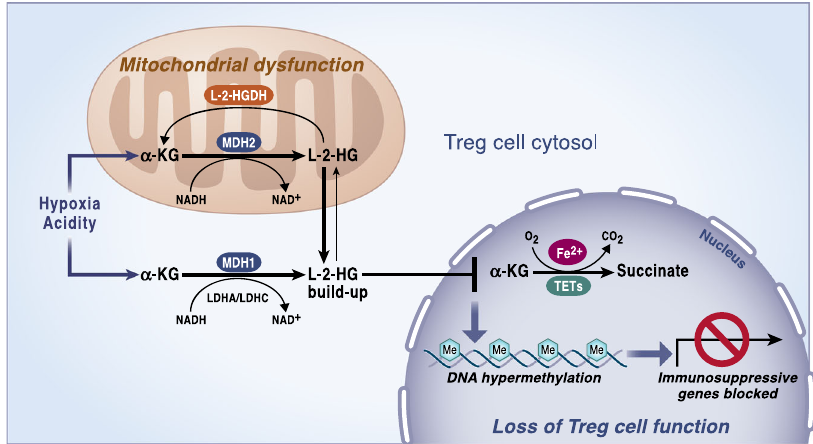
Fig. 6 L-2-hydroxyglutarate (L-2-HG) regulates Treg cells function. Mitochondrial malate dehydrogenase (MDH2), its cytosolic counterpart (MDH1) and lactate dehydrogenases (LDH) A or C in the cytosol can exhibit enzyme promiscuity and catalyze α -KG reduction to L-2-HG. The reaction is coupled with NADH oxidation to NAD + . L-2-hydroxyglutarate dehydrogenase (L-2-HGDH) converts L-2-HG back to α -KG in mitochondria. Accumulated levels of L-2- HG inhibits the activity of TETs, which are enzymes involved in regulating DNA demethylation. TETs consume oxygen and α -KG as co-substrates producing CO 2 and succinate. The reaction requires of Fe 2 + as a cofactor. This mechanism has been observed to speci fi cally repress immunosuppressive genes when mitochondrial complex III is